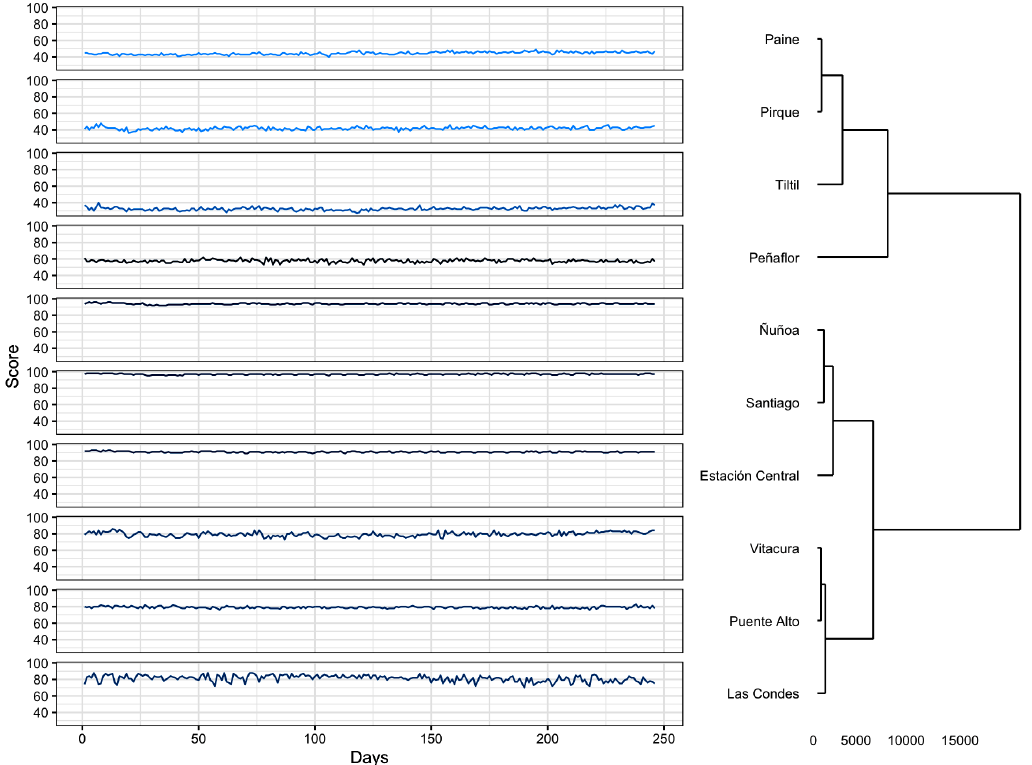
Figure 5. A sample of 10 communes grouped in clusters of similar behavior according to the values of the scores. The central communes of the MR (Ñuñoa, Santiago, Estación Central) have the highest scores, while the peripheral rural communes (Paine, Pirque, Tiltil) have the lowest scores. It is also observed that communes with very different incomes may have similar mobility scores (low-income commune: Puente Alto, and high-income communes: VItacura, Las